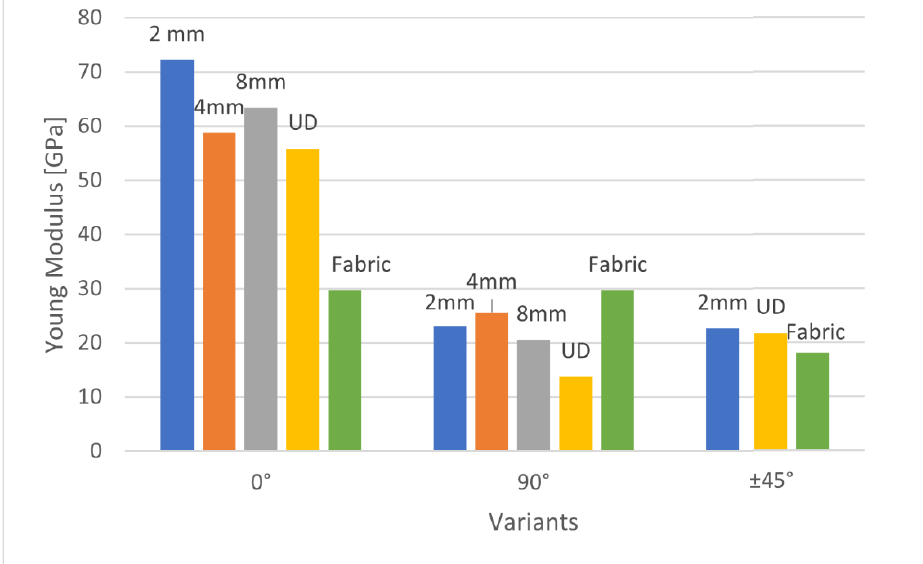
Figure 13. Young modulus of produced composites.